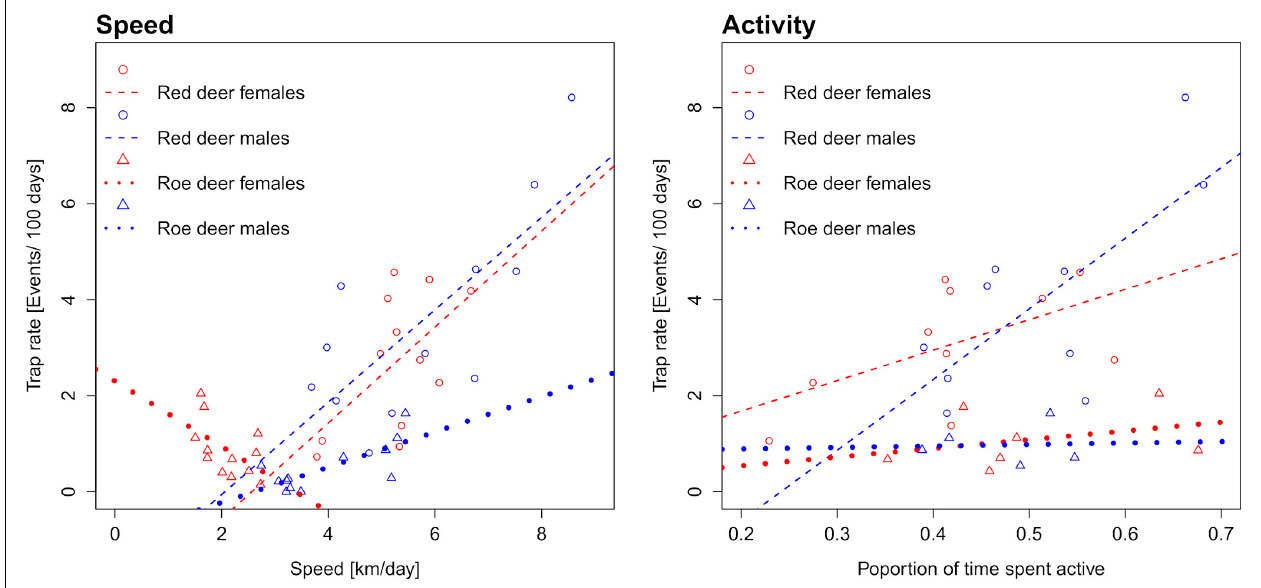
FIGURE 4 | Correlation of monthly activity and movement speed estimates with the trapping rates of red deer and roe deer of both sexes. Activity estimates were computed for all months with at least ten